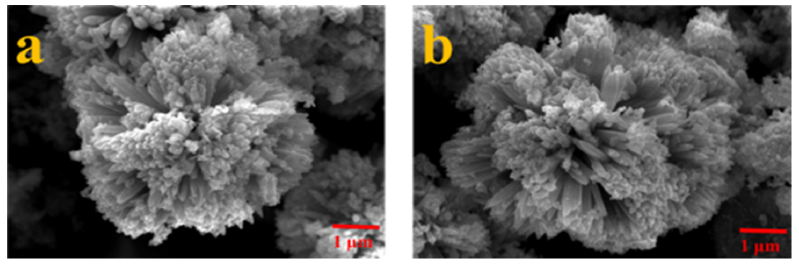
Figure 3. Micrographs of ( a ) ZnO and ( b ) ZnO (ZnO@C) nanorod powder.